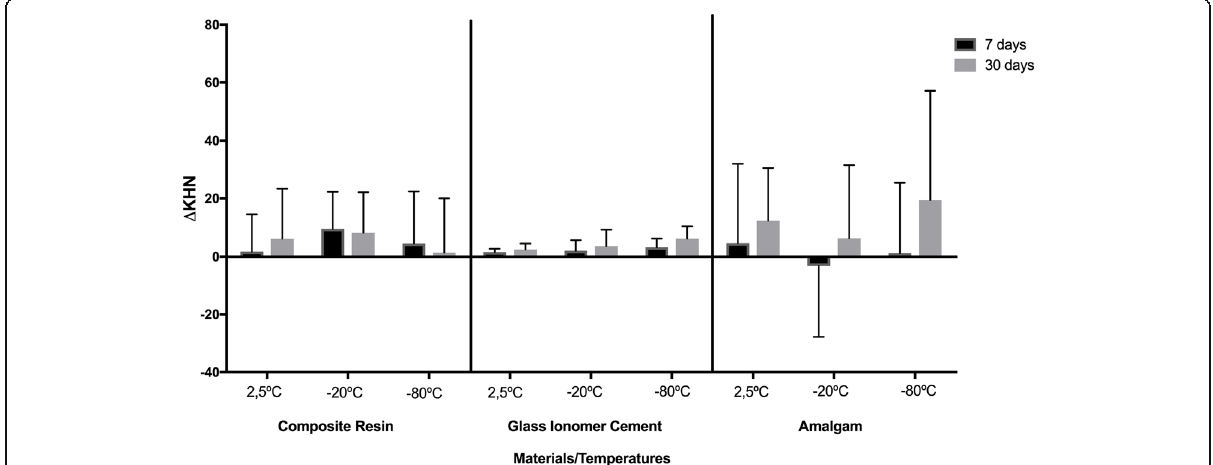
Fig. 3 Graphic representation of the comparison of Δ KHN between the materials when exposed to the cold temperatures (two-way ANOVA, repeated measures, Bonferroni test, p < .05). For all comparisons, p >